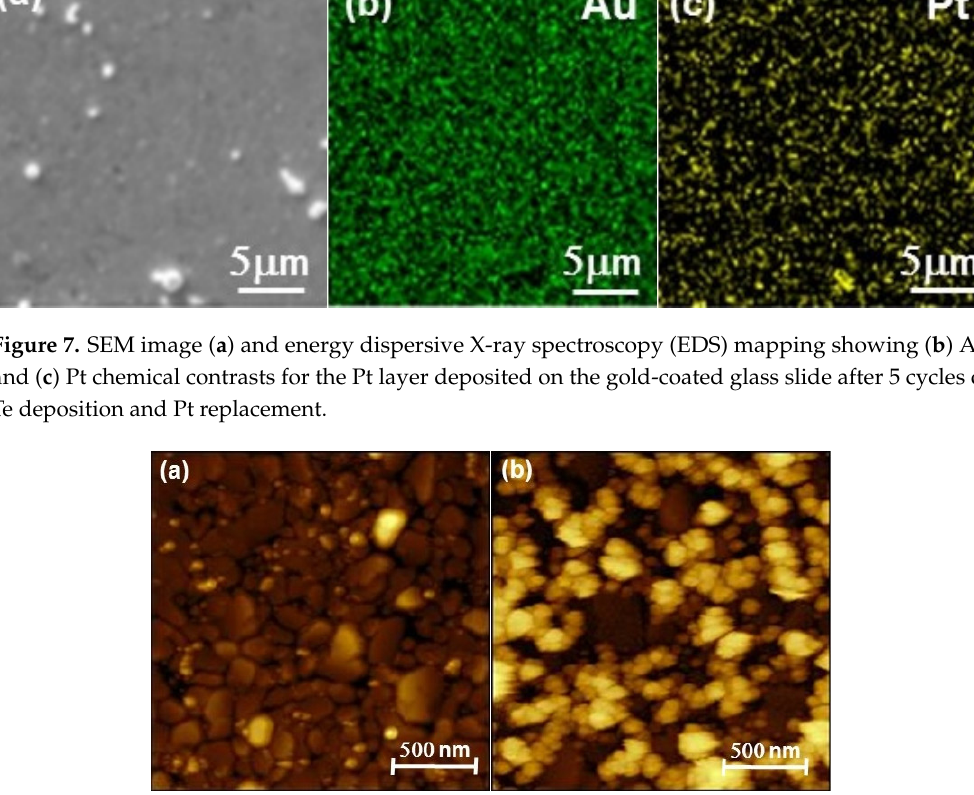
Figure 8. Atomic force microscopy (AFM) micrographs of ( a ) a bare Au-coated glass slide and ( b ) Pt deposit on Au-coated glass slide.